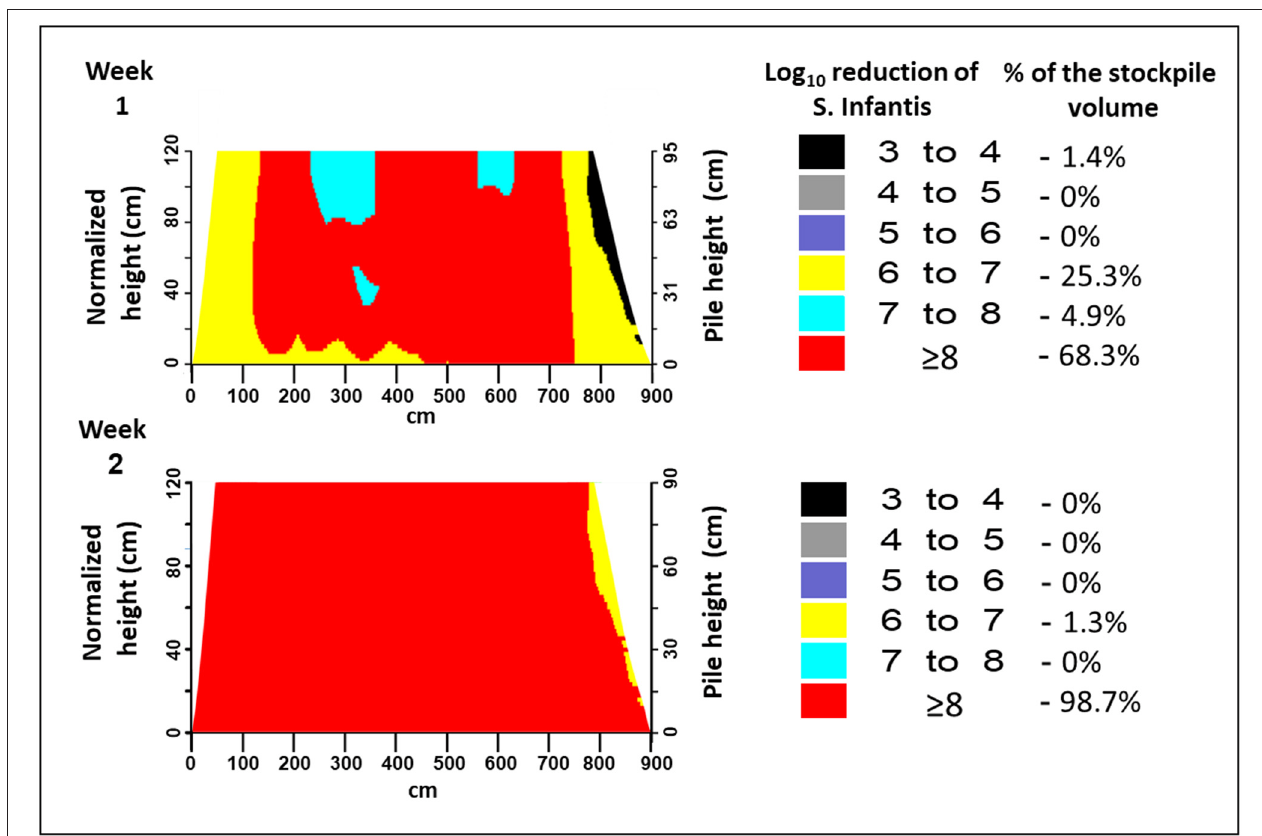
FIGURE 8 | Assessments of the spatial persistence of S. Infantis in the stockpile, based on the exponential decay constants from Avidov et al. (2021a) and the grid maps constructed in this study for temperature, water content, and